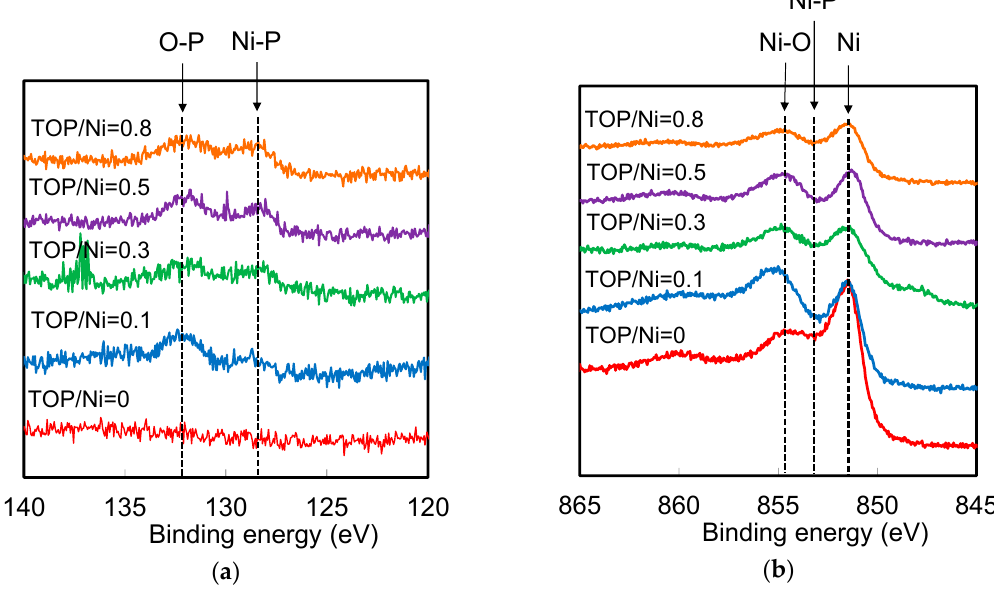
Figure 9. X-ray photoelectron spectroscopy (XPS) ( a ) P 2p3/2 and ( b ) Ni 2p3/2 spectra of the Ni nanoparticles at the TOP/Ni ratios from 0–0.8. Nanomaterials 2016 , 6 , 172